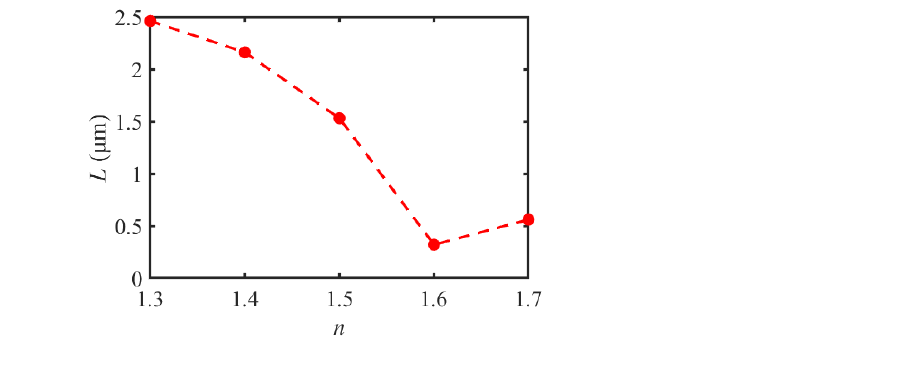
Figure 5. Comparison of the propagation distance L of the SPP-PNJ with different dielectric microdisk refractive indices n .